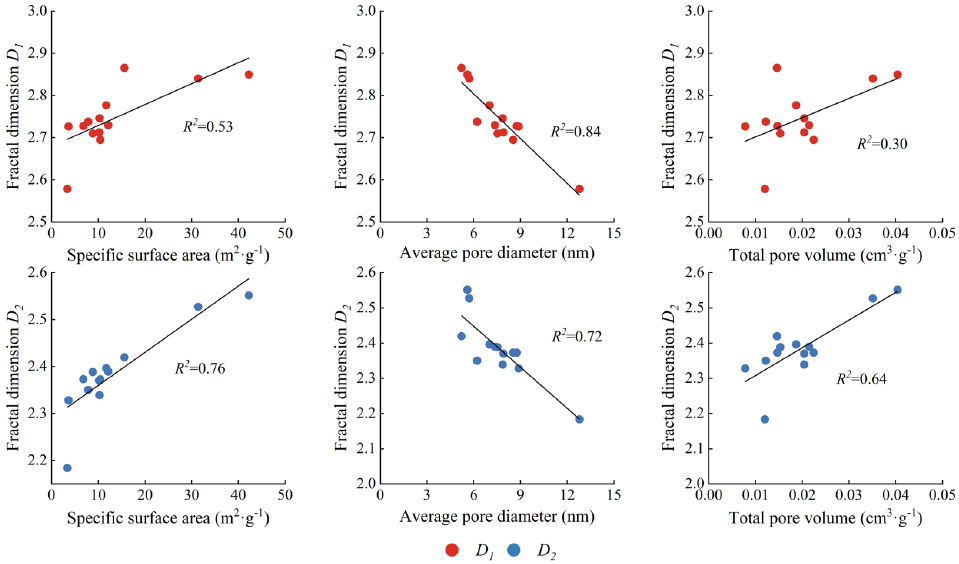
Figure 11. Relationship between pore structure parameters and fractal dimension of Sha-4 shale.